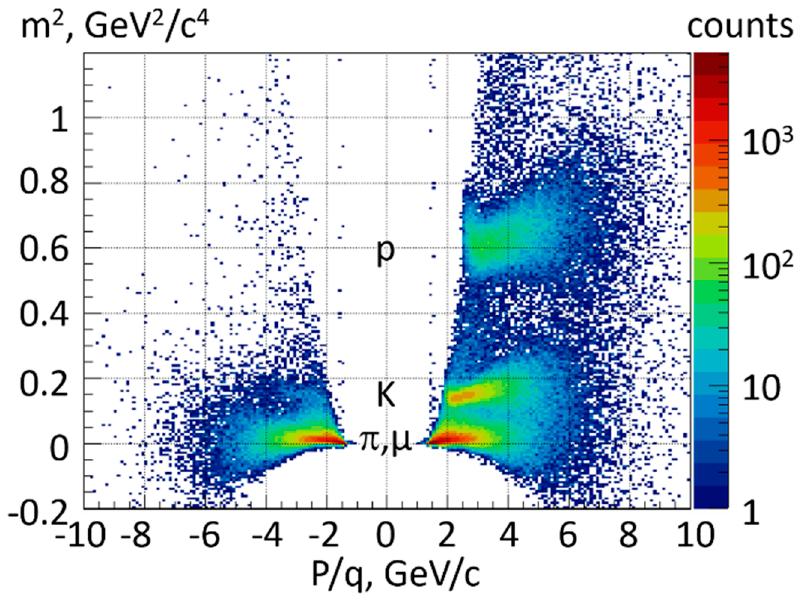
Figure 5. Mass squared versus momentum time charge of particles reconstructed in central Au + Au collisions at 8 A GeV/c.